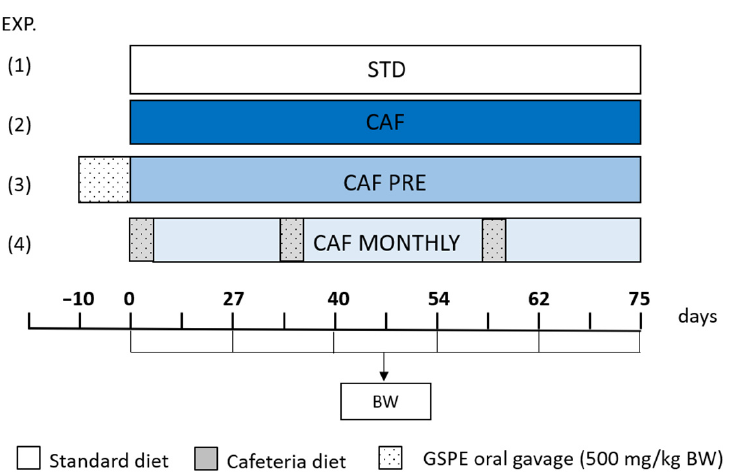
Figure 1. Schematic diagram of the experimental design. All groups were adapted to the environment and to oral gavage during one week before experiment started. Body weight was measured every two weeks. (1) STD: rats receiving standard diet during the whole experiment; (2) CAF: rats receiving standard diet before cafeteria diet intervention; (3) CAF PRE: rats receiving GSPE preventive treatment for 10 days before the cafeteria diet intervention started; (4) CAF MONTHLY: rats receiving a 5-day GSPE treatment simultaneously with the cafeteria diet once per month. Ab-